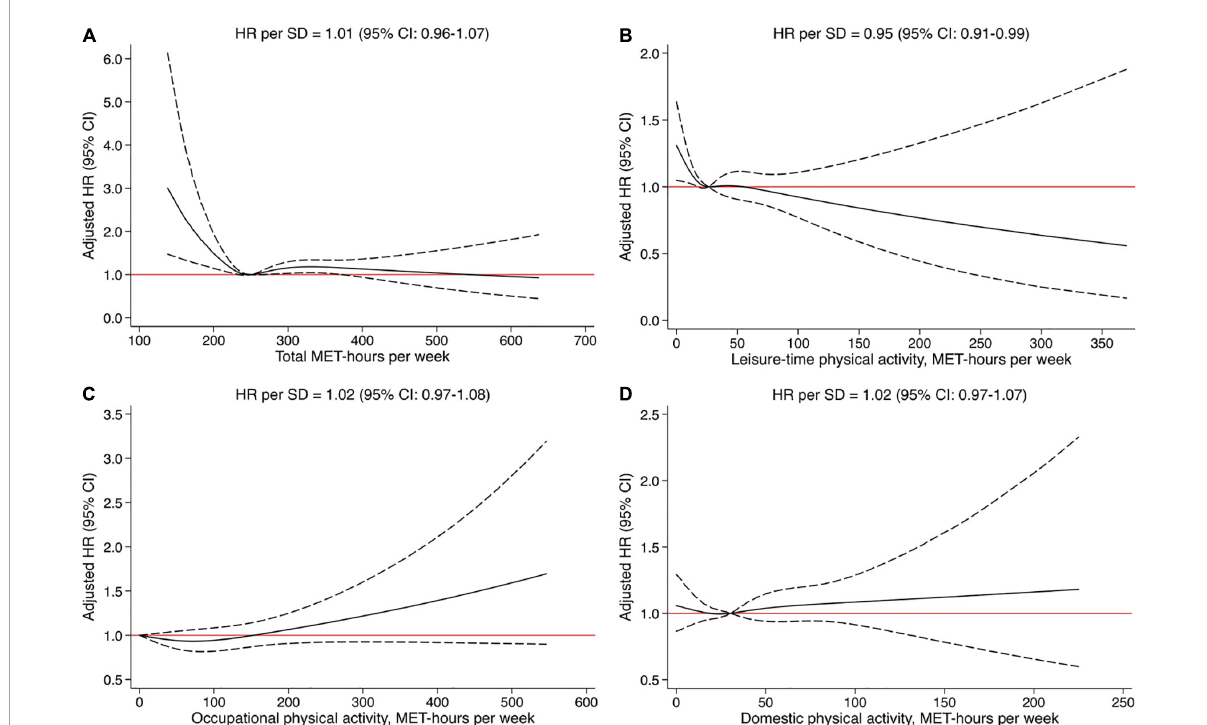
FIGURE3 (A–D) Restricted cubic splines fitted to Cox regression models showing the associations between physical activity measures and risk of atherothrombotic ischemic stroke. Solid line represents the adjusted hazard ratio (HR) and dashed lines the 95% confidence intervals. All models were adjusted for age, sex, educational level, and smoking